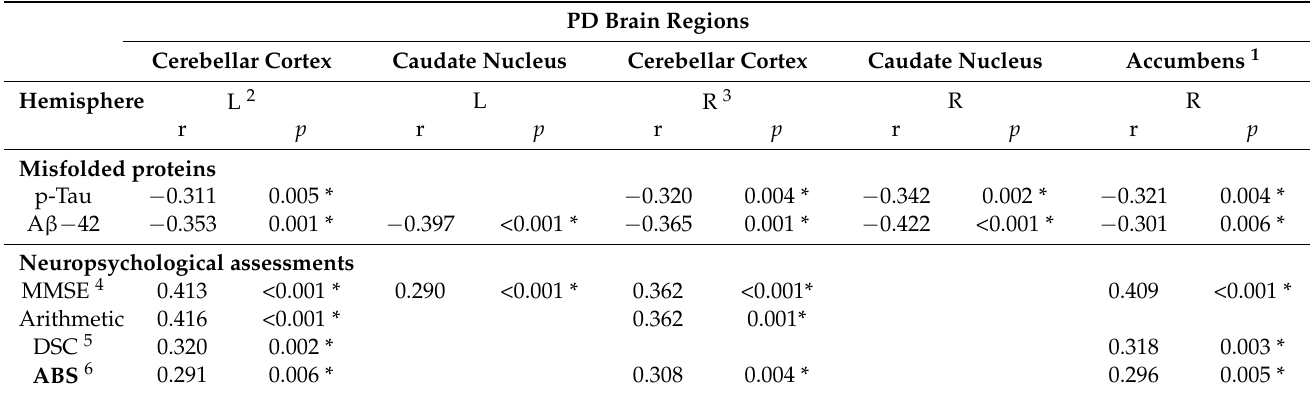
1 Accumbens (Accumbens area); 2 L (left), 3 R (right); 4 MMSE (mini mental state examination); 5 DSC (digit symbol coding); 6 ABS (abstract thinking). * Indicates Bonferroni adjusted p < 0.05.